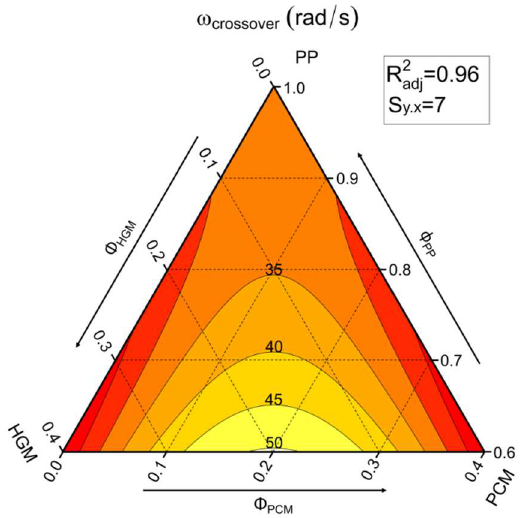
Figure 2. Ternary diagram representing the frequency values of the crossover point derived from rheological tests on the prepared foams.